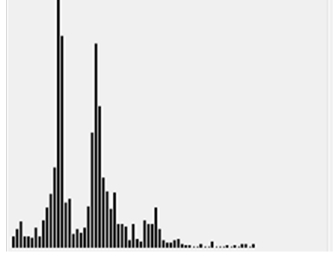
Figure 3. An example of label histogram 𝐿𝐻 (cid:3046) .